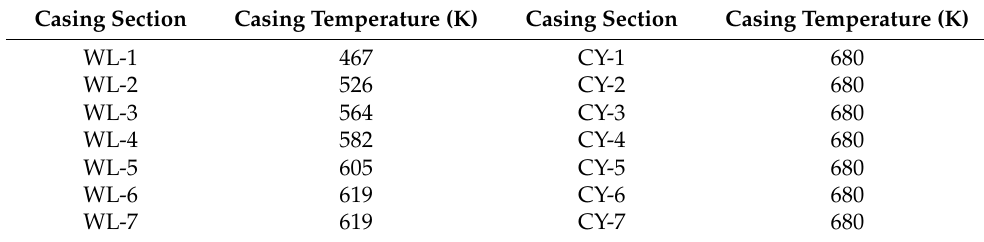
Table 2. Temperature distribution on the casing surface.